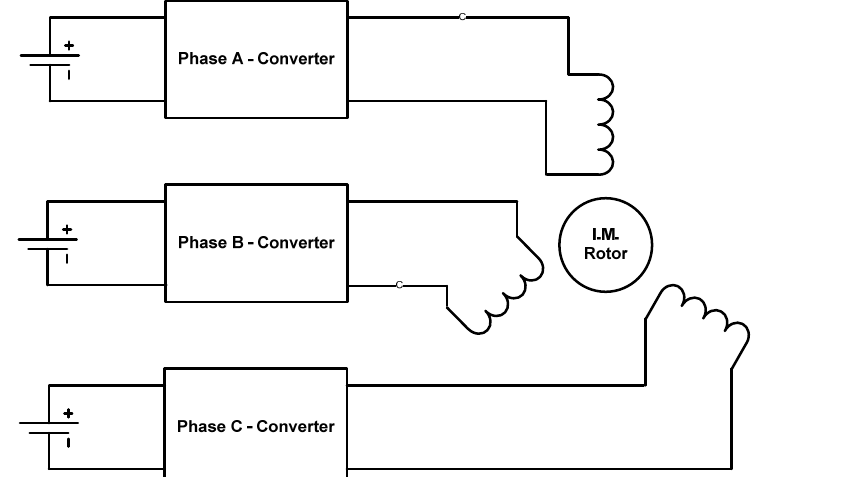
Figure 3. Suggested Golf car drive system.